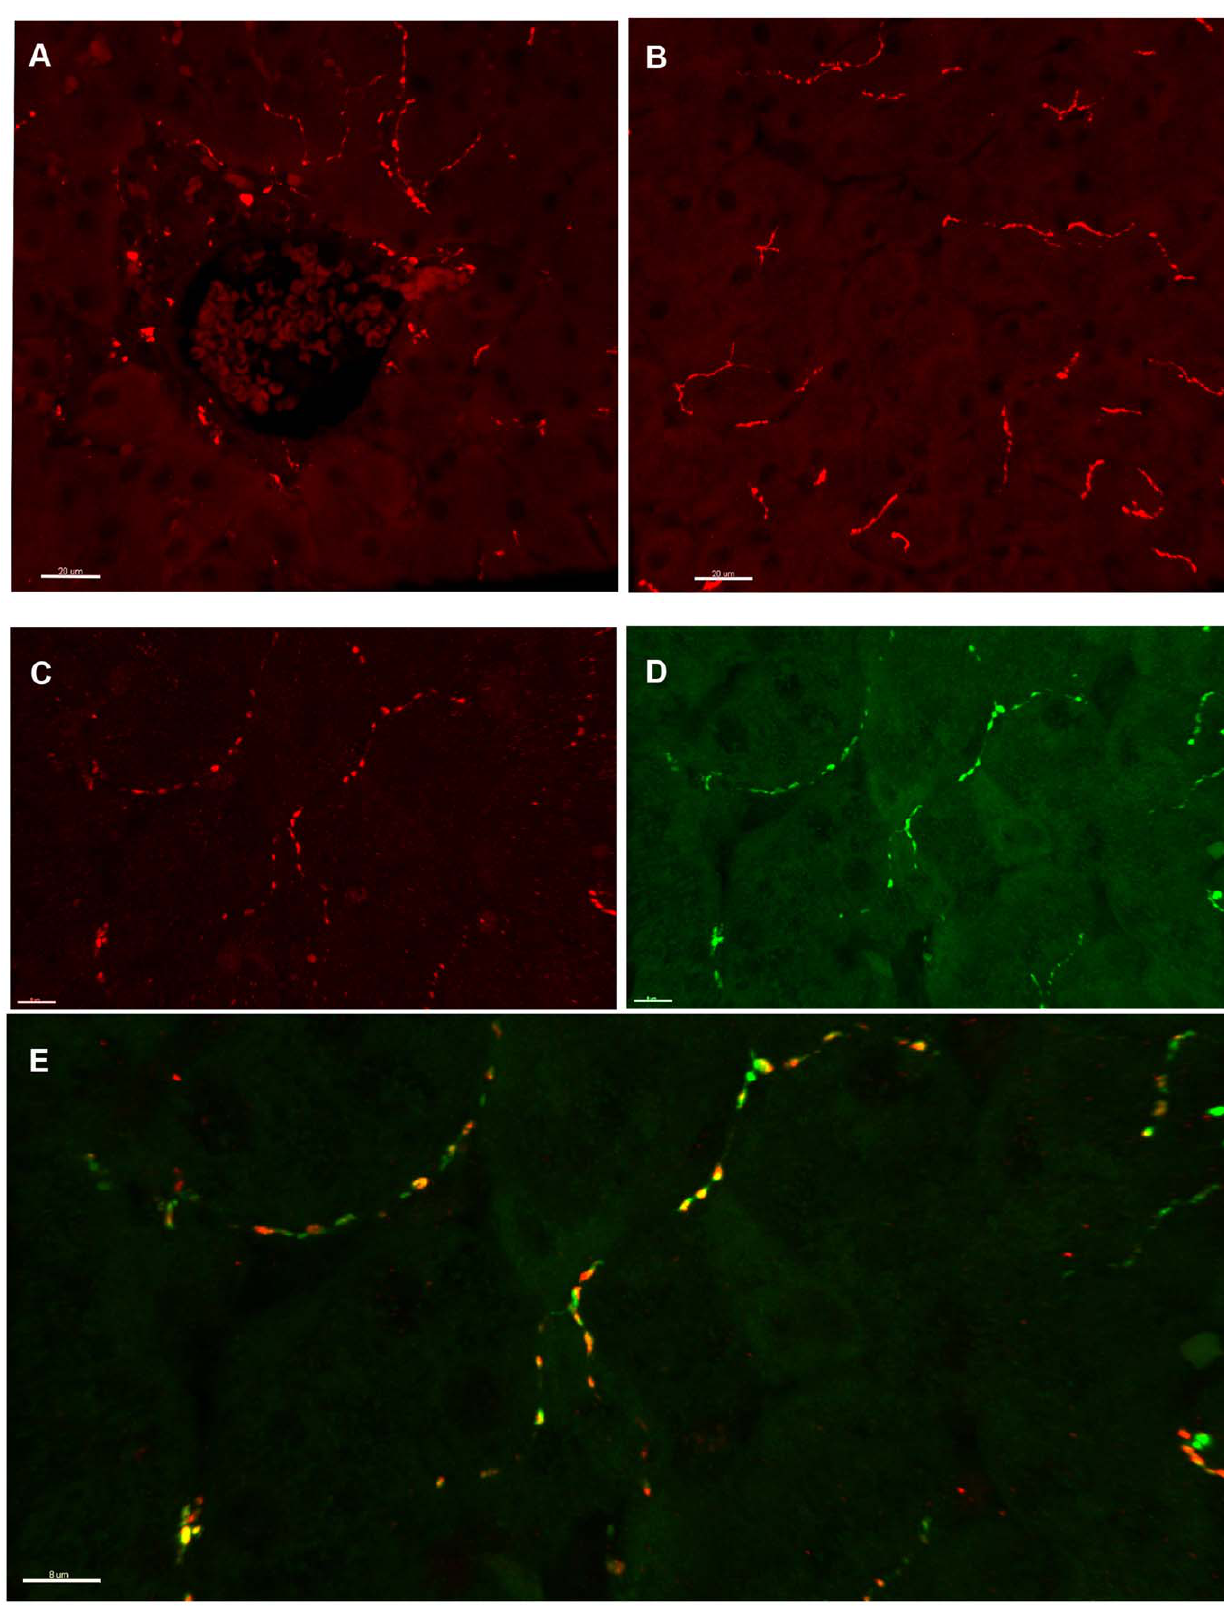
Figure 3. Hepatic sympathetic innervation in the one-year old juvenile macaque. (A-B) Representative image of TH immunoreactive nerve fibers in the portal region (A) and parenchyma (B) in juvenile liver. Scale bar=20 m m. (C-E) Colocalization of NPY and TH immunoreactivity in the